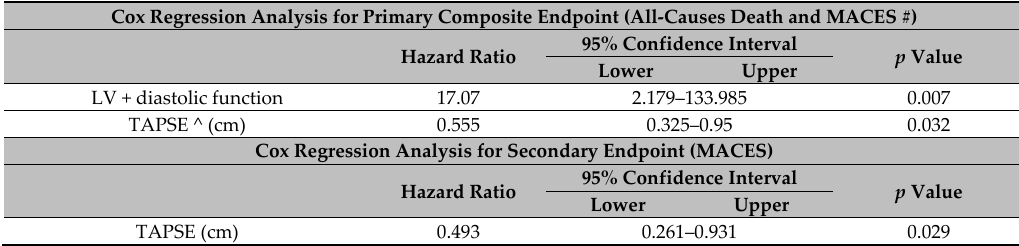
Table 4. Cox regression analysis results for the significative parameters.